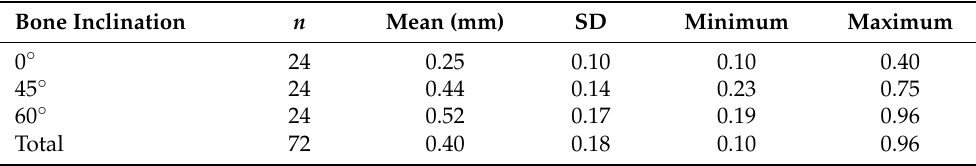
Table 9. Results of descriptive statistics of 3D deviation at coronal in varying bone